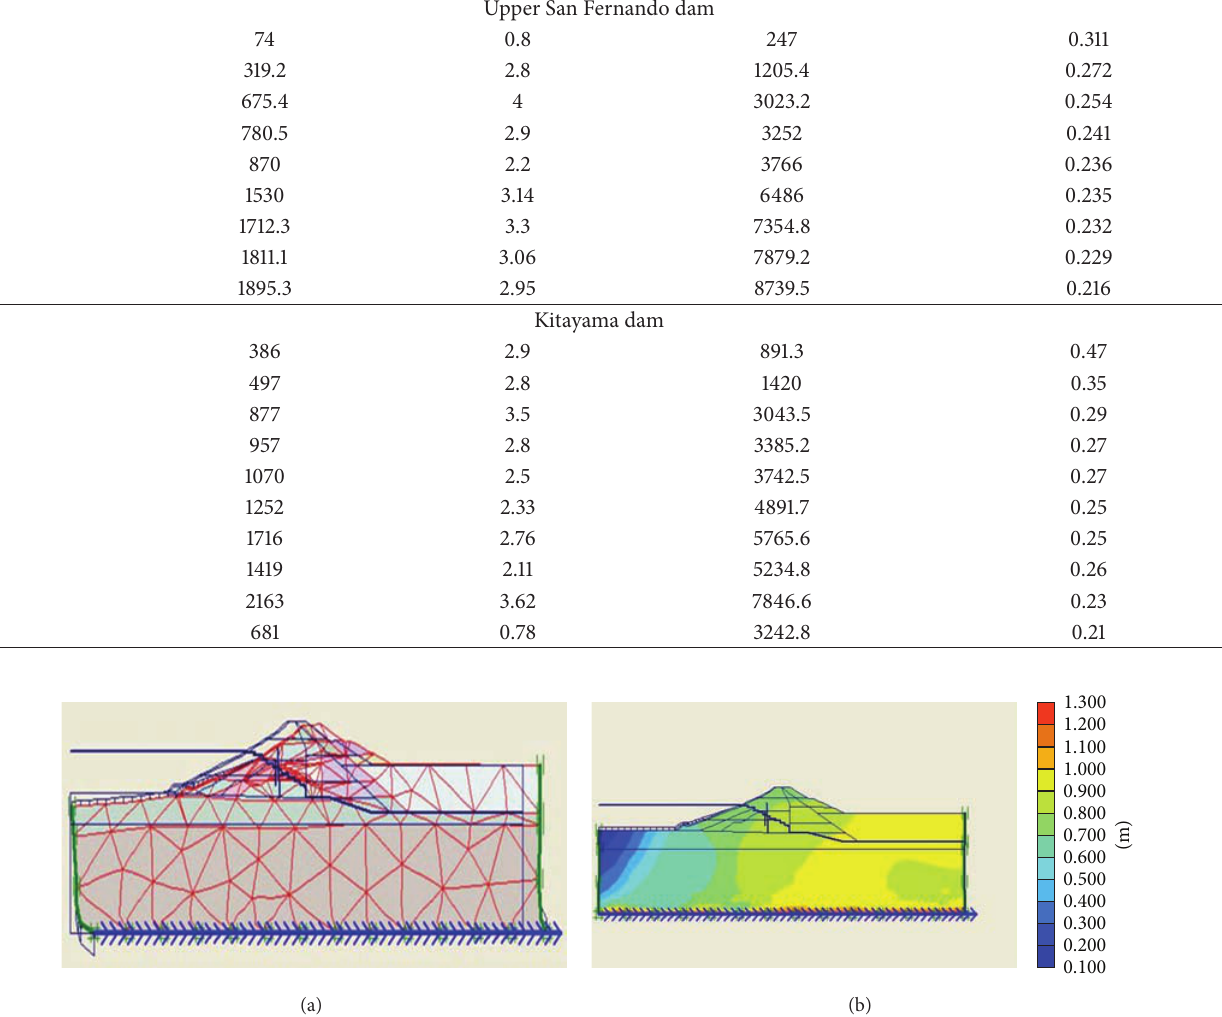
Figure 8: Whole deformations and horizontal displacements of Kitayama dam.